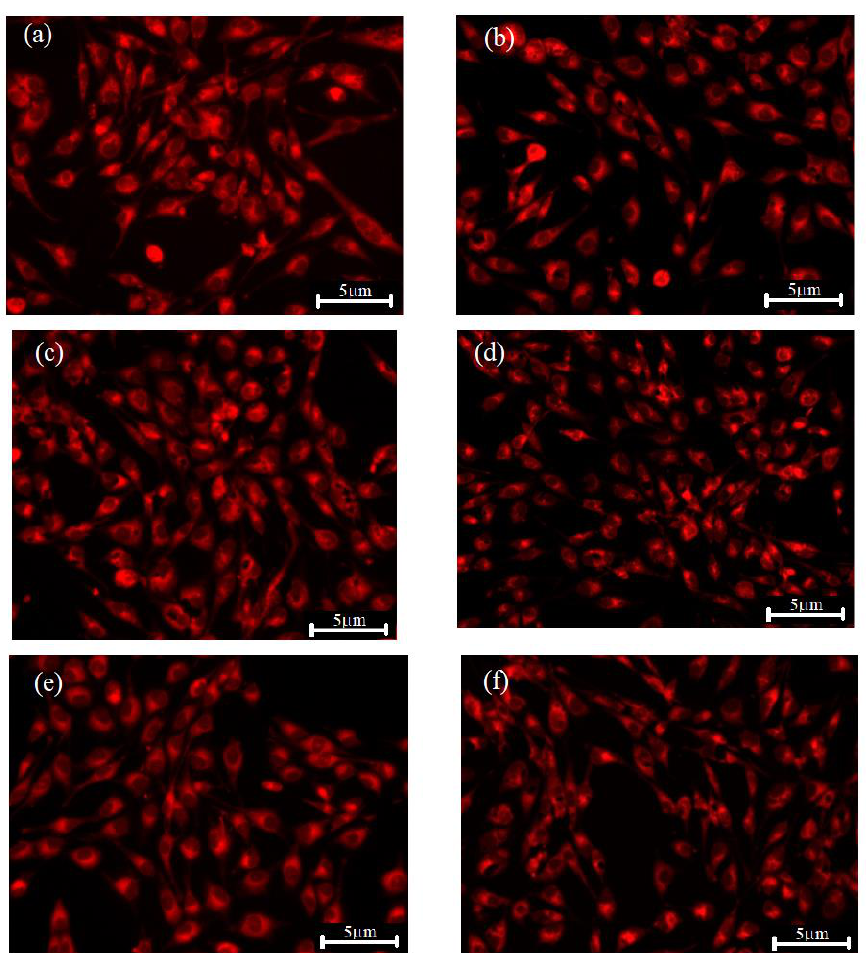
Figure 11. Fluorescence images of Ca 10-x Ce x (PO 4 ) 6 (OH) 2 samples colored with CMTPX fluorophore ( a ) control sample, ( b ) x = 0.5; ( c ) x = 1; ( d ) x = 2.5; ( e ) x = 5; ( f ) x = 10%. After 5 days in the presence of cerium-doped HAp powders, the AFSC showed nor- mal morphology with a fibroblast-like characteristic appearance. Fluorescence images showed that the AFSC were viable, no dead cells or cell fragments were observed. More- over, the cells formed filopodia to move and establish contacts with neighboring cells, suggesting that AFSC exhibited an active phenotype. Furthermore, the picture of a nega- tive control (dead cells) for the fluorescent microscopy images was represented in Figure 12. The negative control is represented by the AFSC treated with H 2 O 2 , 10 mm .